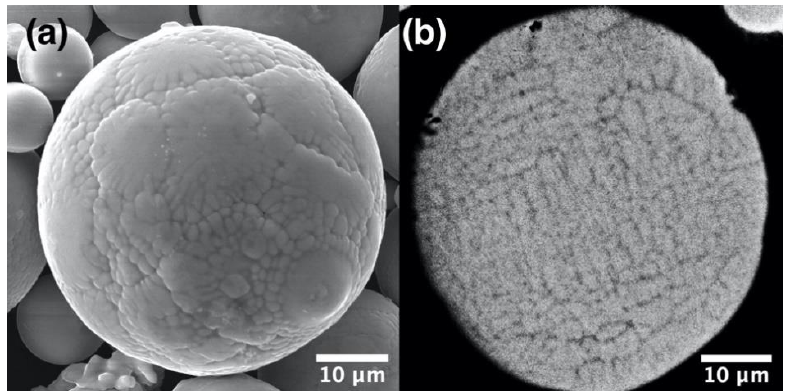
Figure 1. Scanning electron microscope (SEM) images of the gas atomized powder (GA) showing ( a ) surface morphology and ( b ) cross-section of a particle. ( a ) surface morphology and ( b ) cross-section of a